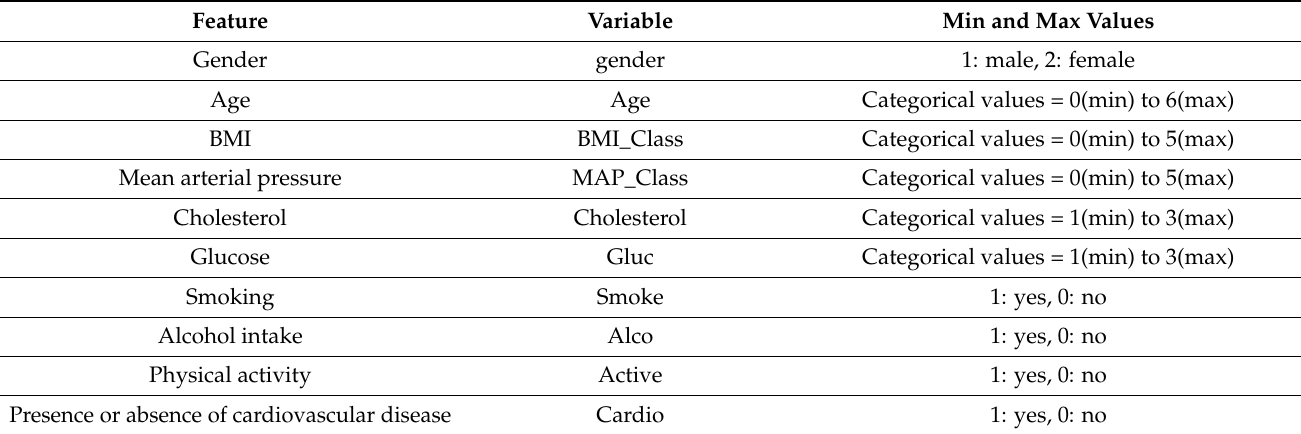
Table 4. Final attributes after feature selection and